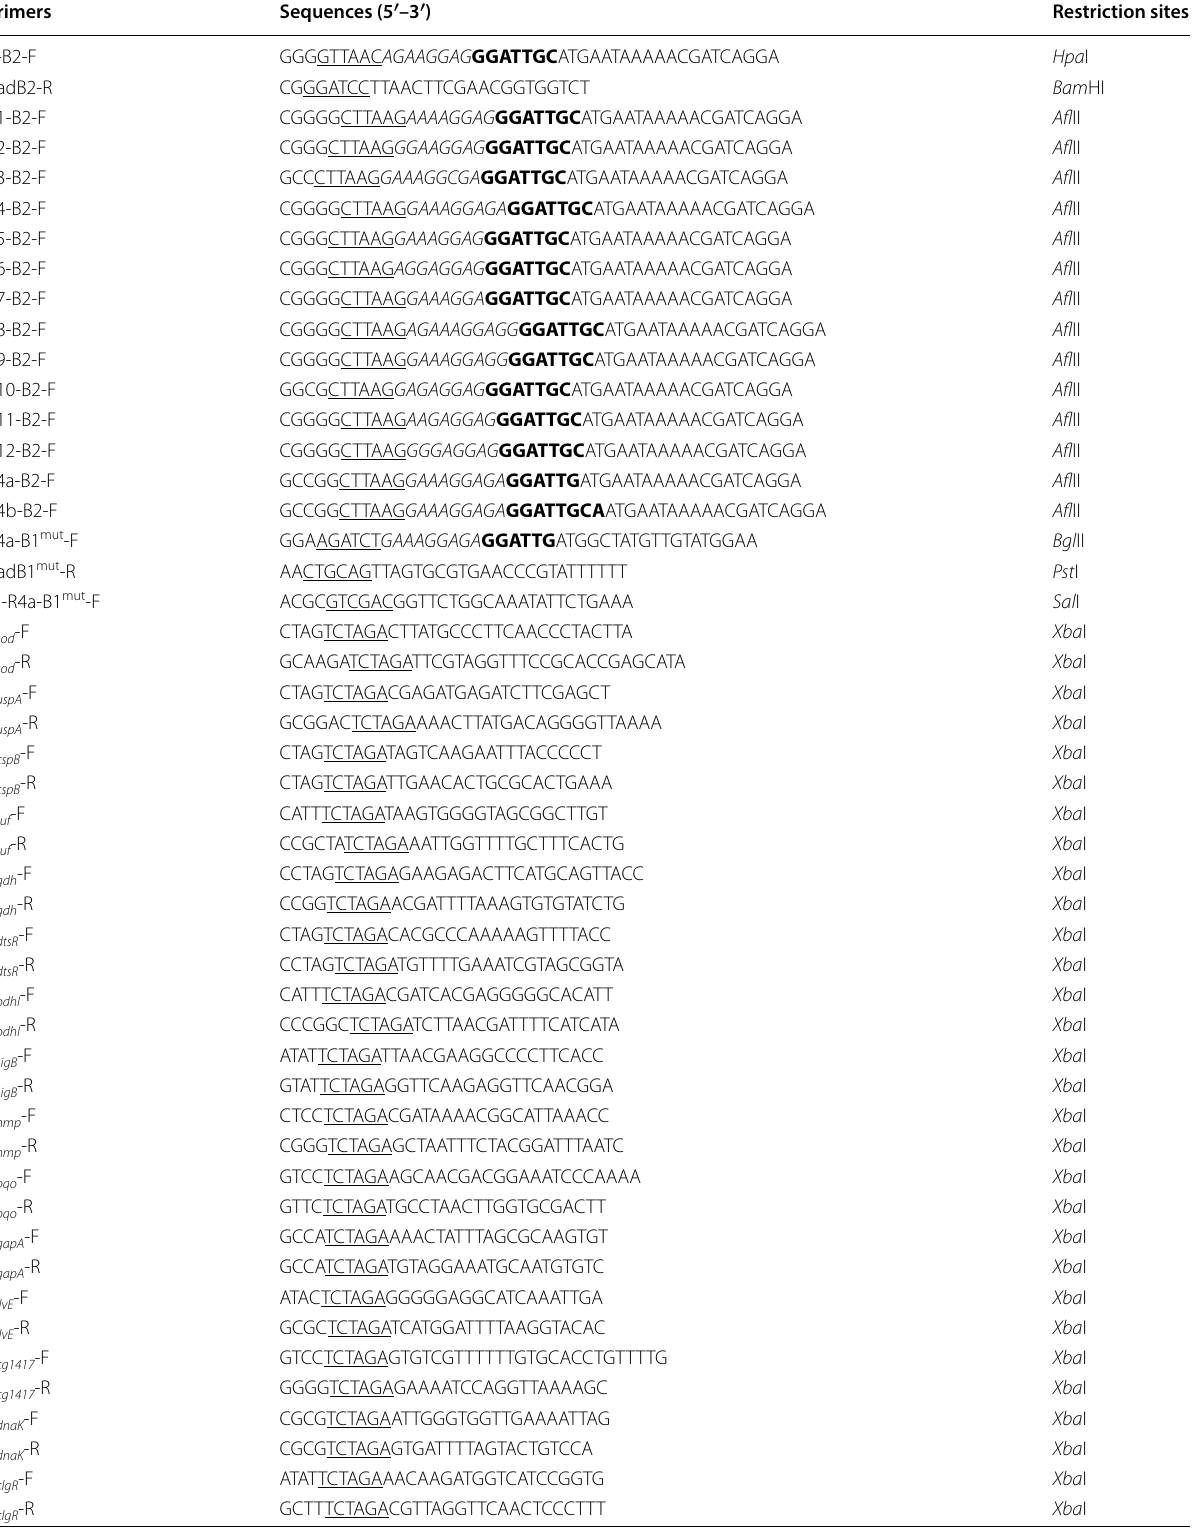
Table 2 Primers used in this